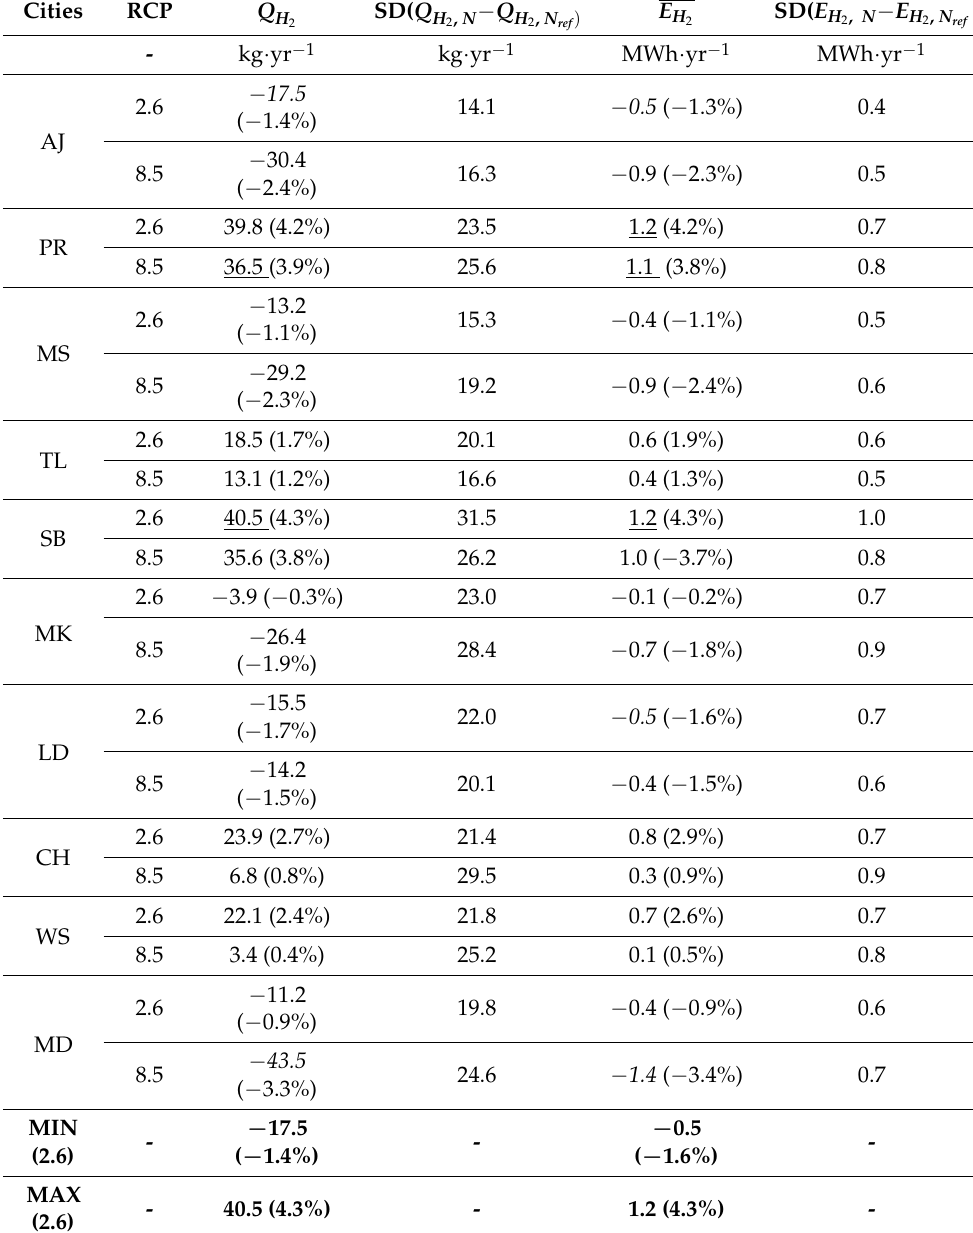
Table 7. Climate change tendencies for only the 10 studied sites between 2005 and 2100. Data are provided in absolute (kg · yr − 1 or MWh · yr − 1 ) and relative (%, parentheses) values. Italic and underlined characters respectively represent minimum and maximum values.